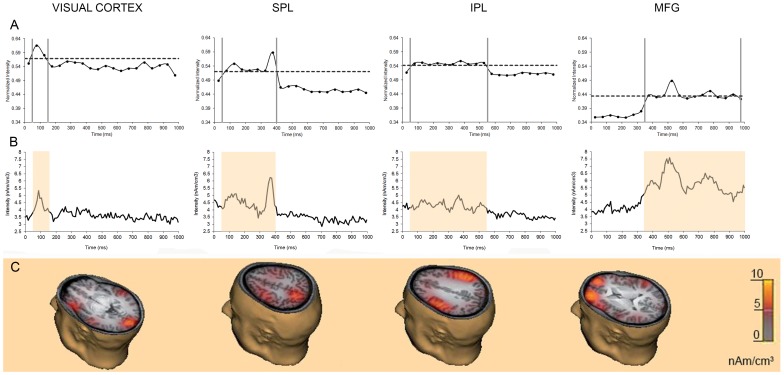
MEG results.A: Mean normalized intensity across all conditions and subjects over time for selected ROIs. Vertical bars indicate the temporal intervals with the highest intensity values established by statistical analysis. Horizontal line indicate the cut-off value (mean+sd). B: Group mean temporal activity was averaged for all conditions for areas showing strongest activity after the matching stimulus. Coloured bars indicate temporal intervals determined previously from statistical analysis and used in the following statistical analyses to compare source activity across conditions (50–150 ms for visual cortex, 50–400 ms for superior parietal lobe, 50–550 ms for inferior parietal lobe and 350–1000 ms for middle frontal gyrus); C: Spatial maps of activations for each areas.